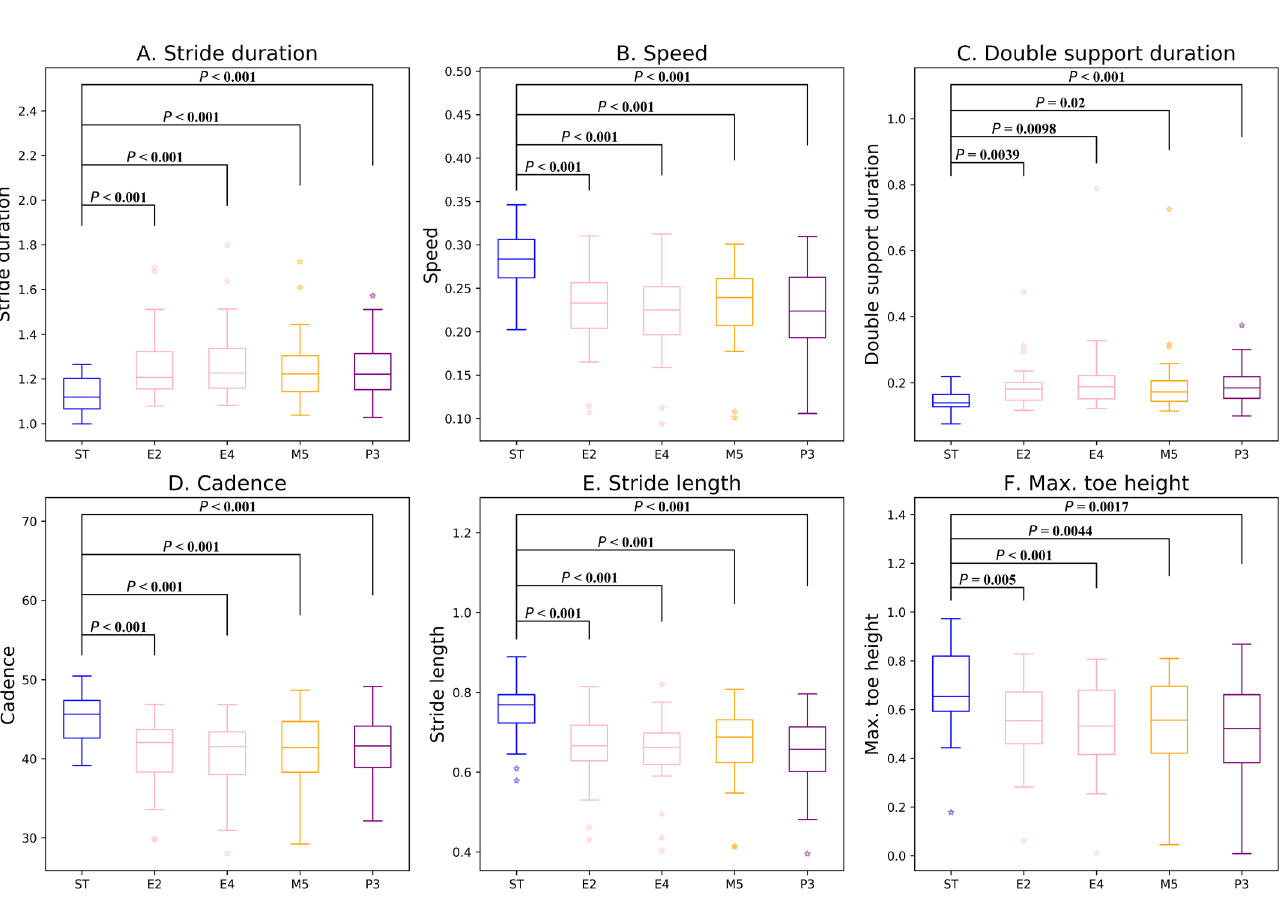
Figure 5. Boxplots showing the dual-tasking activities with the highest load on the gait for the most significant parameters (see Table 5).